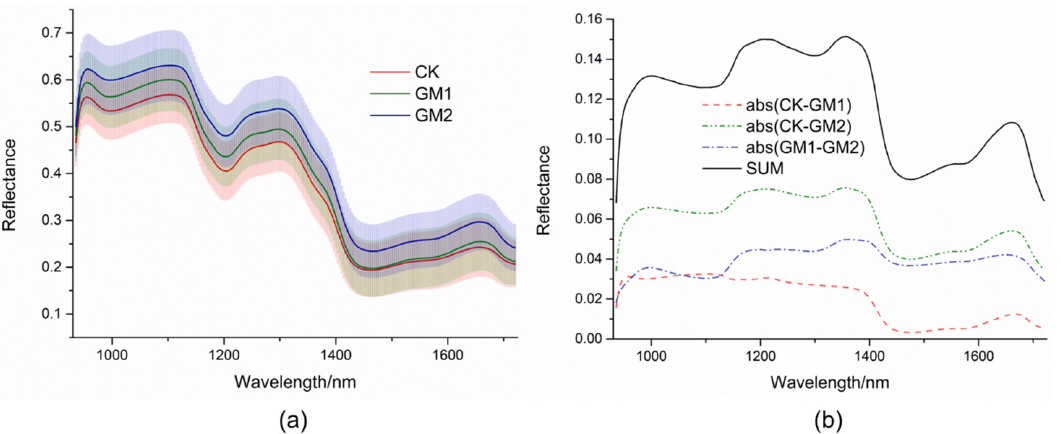
Figure 2. Overview of average spectra with STD ( a ) and the reflectance intensity difference between different categories ( b